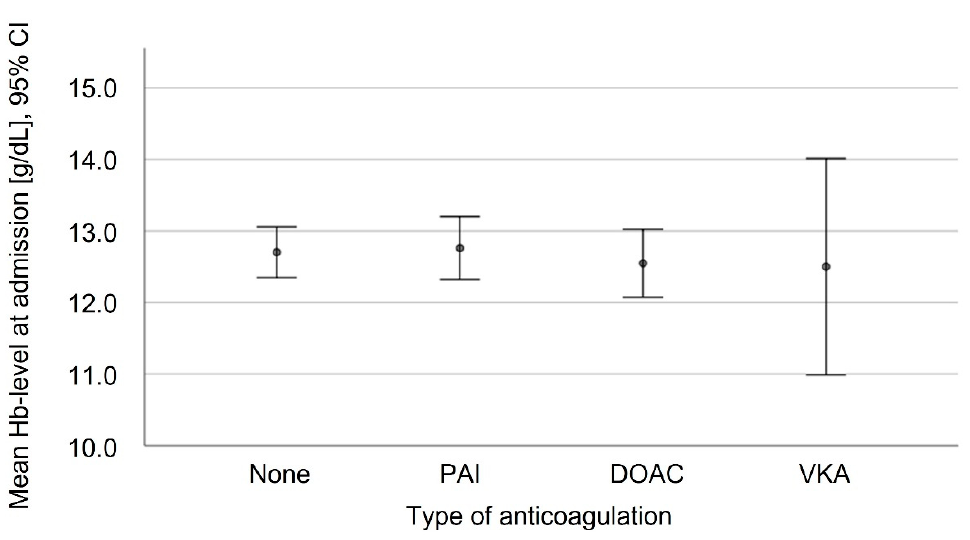
Figure 3. Red blood cell transfusion (RCBT) depending on anticoagulative medication. PAI: Platelet aggregation inhibitors including acetylsalicylic acid; DOAC: Direct oral anticoagulants; VKA: Vitamin-K-antagonist Warfarin.